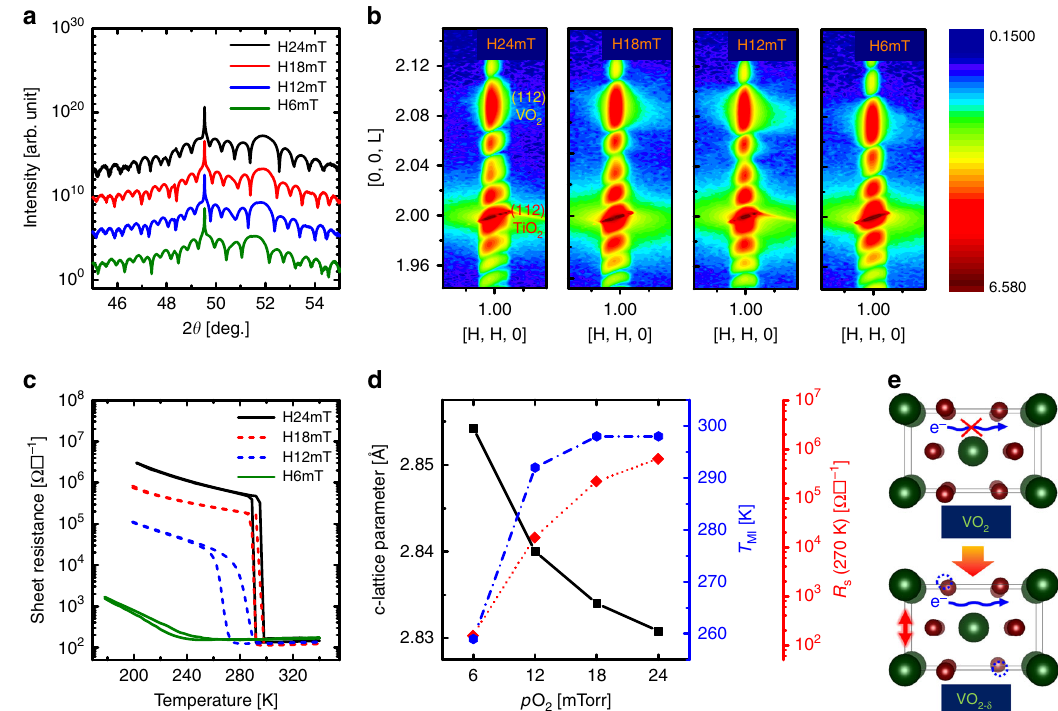
Fig. 3 Structural/electronic modulation by directional ionic transport. a Symmetrical X-ray scan and b reciprocal space mapping around (112) re fl ection of TiO 2 grown under pO 2 = 6 mTorr (denoted as H6mT) ~ 24 mTorr (denoted as H24mT) on VO 2 -templated TiO 2 substrates. These results con fi rm that entire layers in all heterostructures are coherently strained by TiO 2 substrates, but only VO 2 peaks shifted to lower scattering angles as pO 2 decreased during TiO 2 growth. c Temperature-dependent sheet resistance ( R S ) in all TiO 2 /VO 2 /TiO 2 heterostructures with TiO 2 epitaxial fi lms grown at 6 ≤ pO 2 ≤ 24 mTorr on VO 2 -templated TiO 2 substrates. d Lattice parameter ( c ) from a and temperature ( T MI ) of metal-insulator transition and R S at 270 K from c as a function of pO 2 during TiO 2 growth. e The formation of oxygen vacancies in VO 2 by ionic transfer across the TiO 2 /VO 2 interface expanded the lattice to compensate for the larger cation radius of V 3 + (3 d 2 ) than V 4 + (3 d 1 ), and also led to the oxygen-vacancy-induced